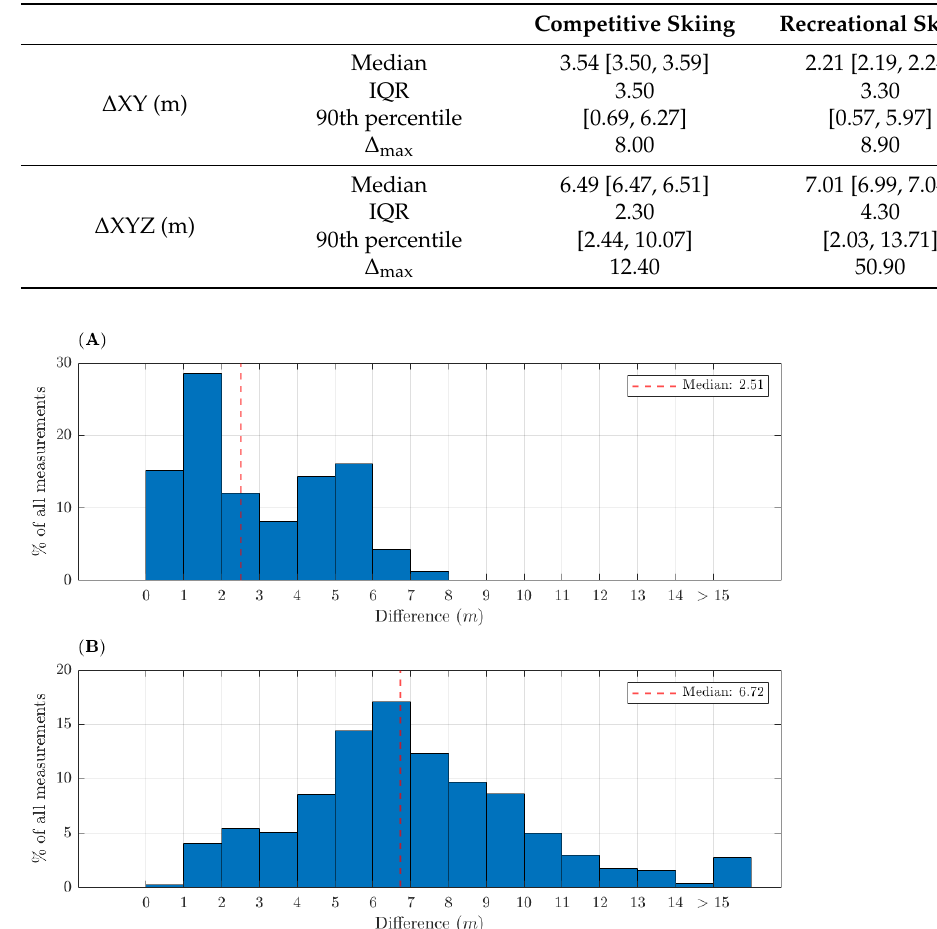
Figure 1. Histograms for horizontal position error ( A ) and position error in three dimensions ( B ) for all skiing data (competitive skiing and recreational skiing data pooled